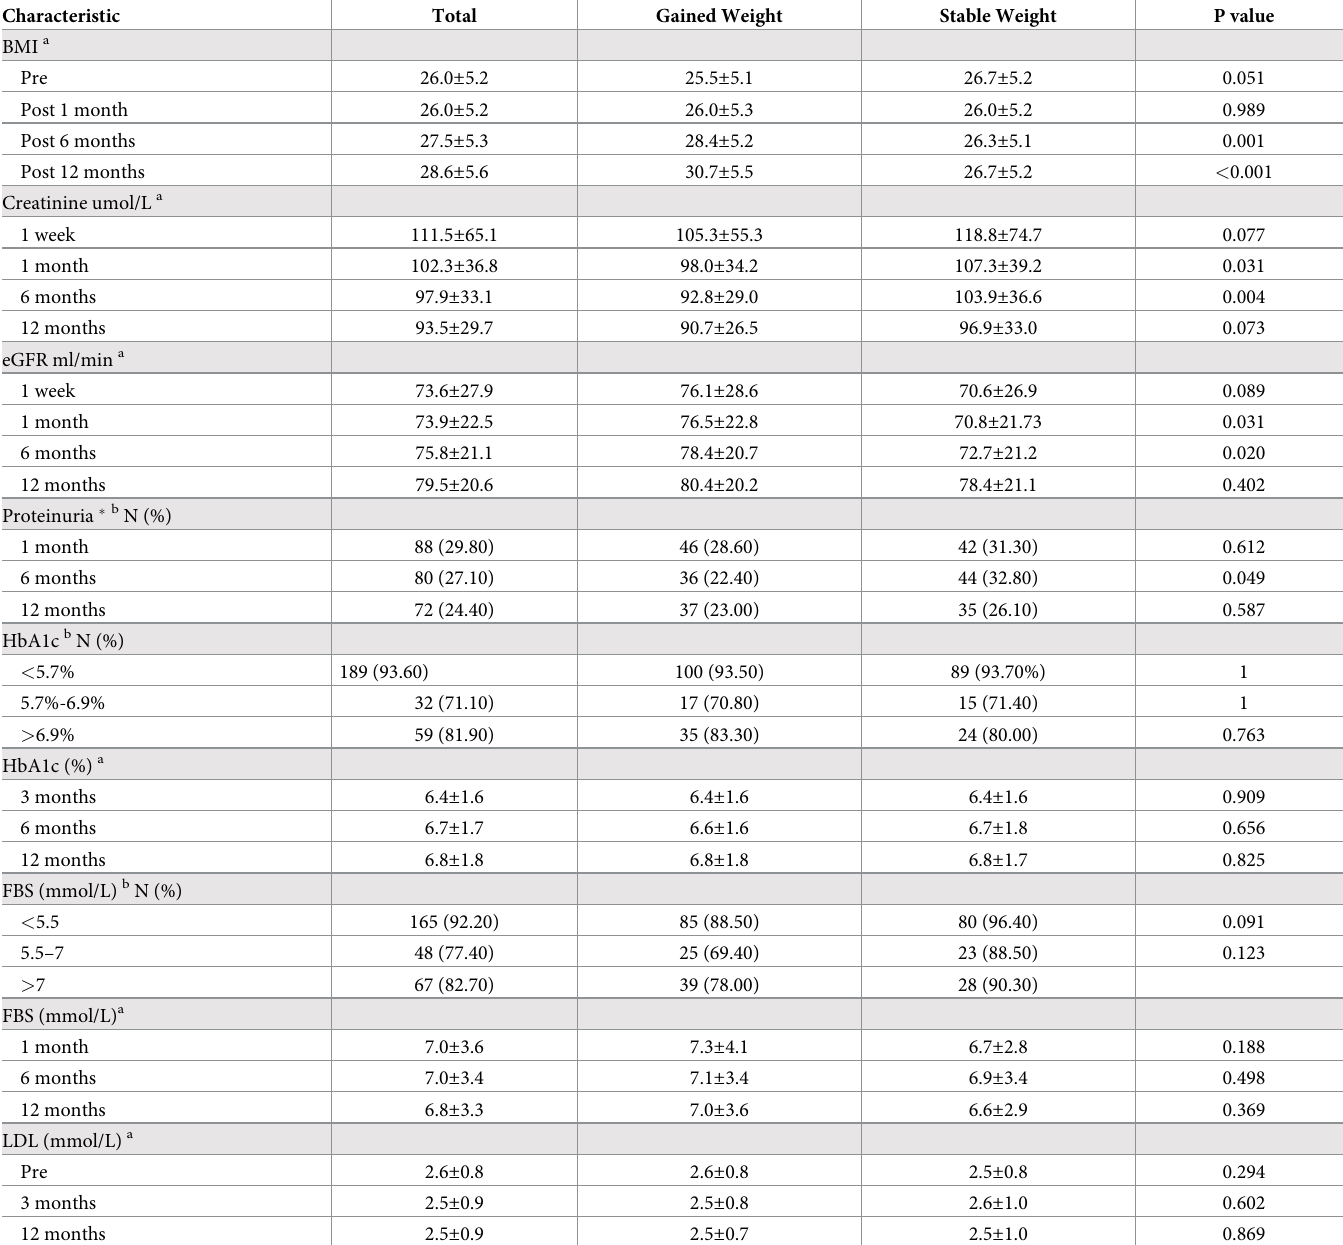
Table 2. Metabolic & laboratory